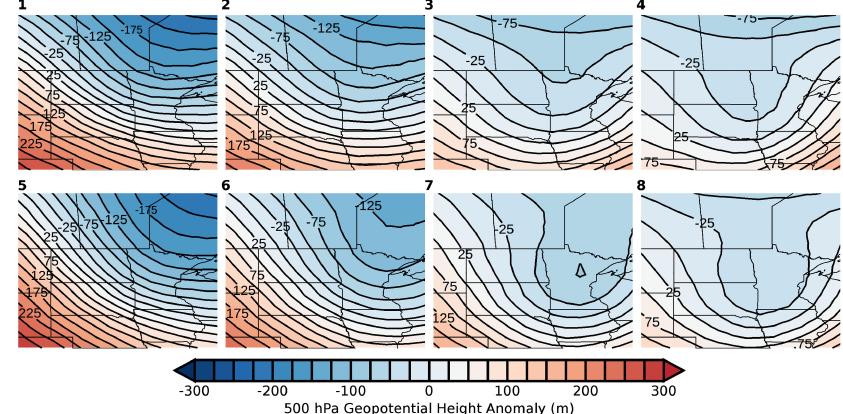
Figure 10. As in Figure 9, except for 500 hPa height anomalies (shaded and dashed